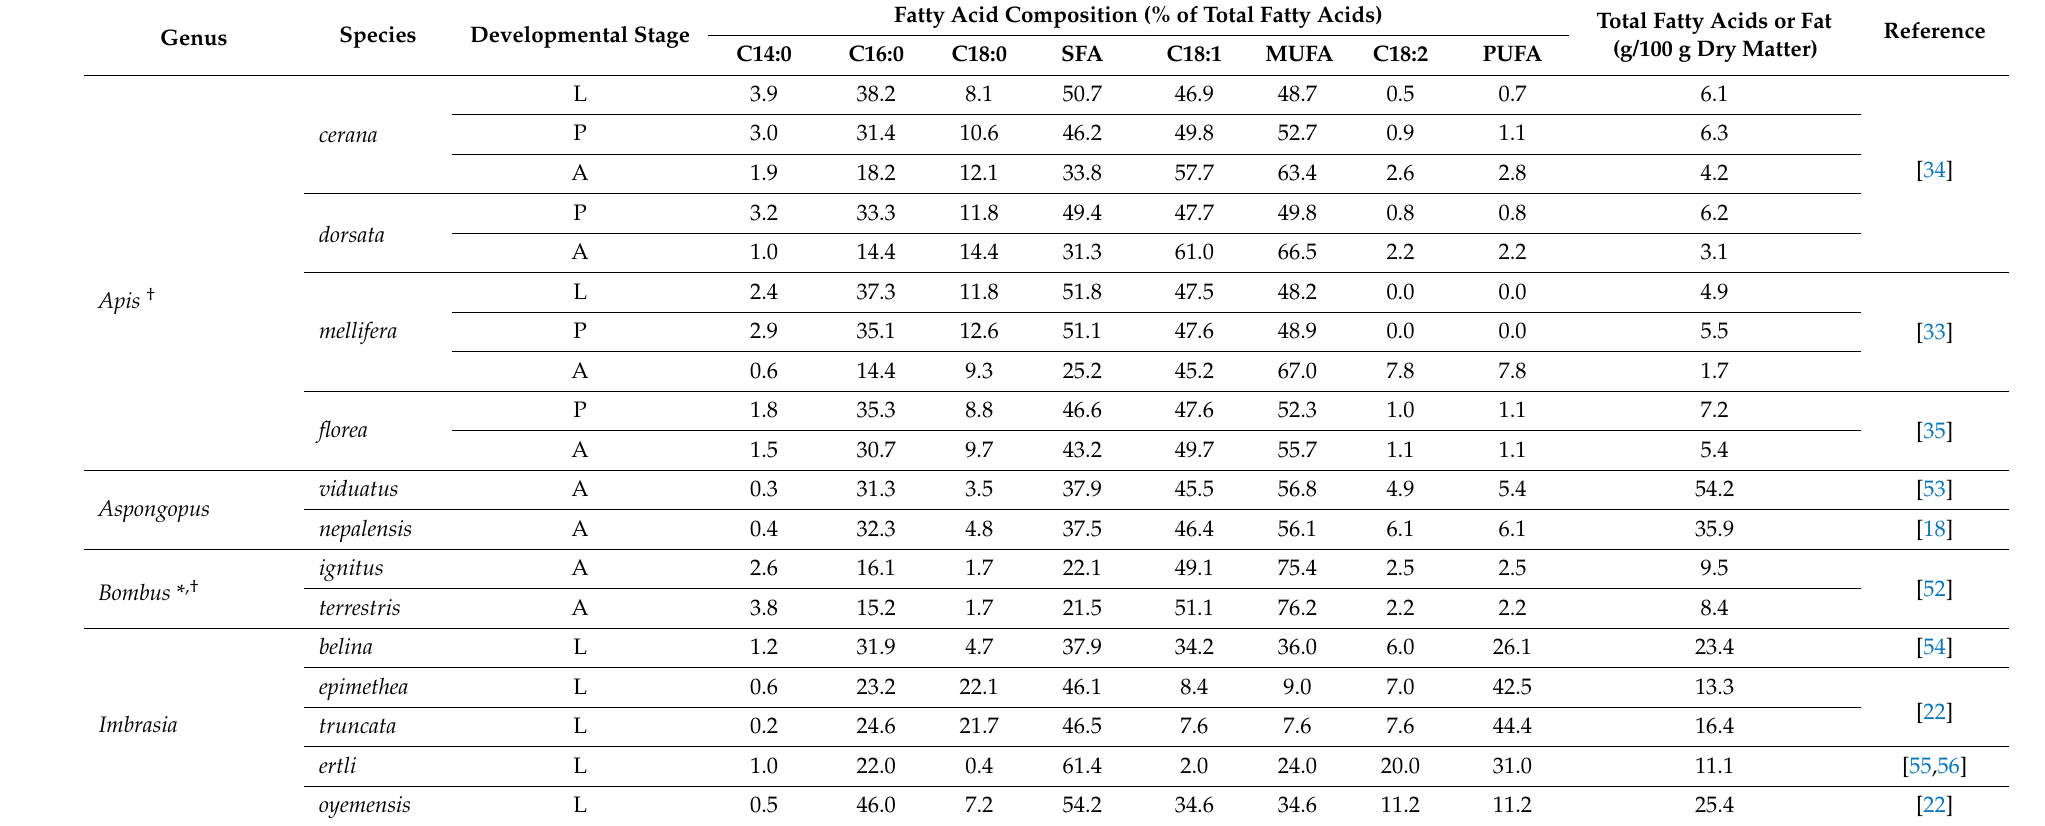
Table 4. Fatty acid composition of selected edible